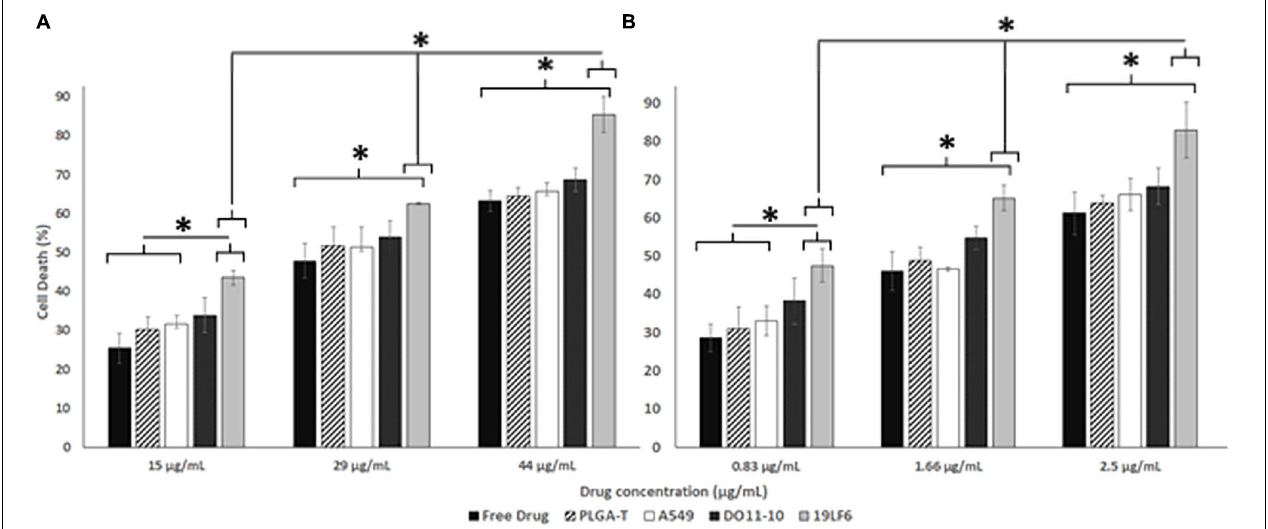
FIGURE 4 | Therapeutic efficiency of T-MNPs. Therapeutic capabilities of T-MNPs, D-MNPs, A-MNPs, NNPs and free Trametinib on (A) 1520 melanoma cell line and (B) DM-6 melanoma cell lines. Cell were exposed to the nanoparticle suspensions for 72 h (ranging concentrations from IC25 to IC75), and cell viability was evaluated using MTS assays. *Statistically significant with P <